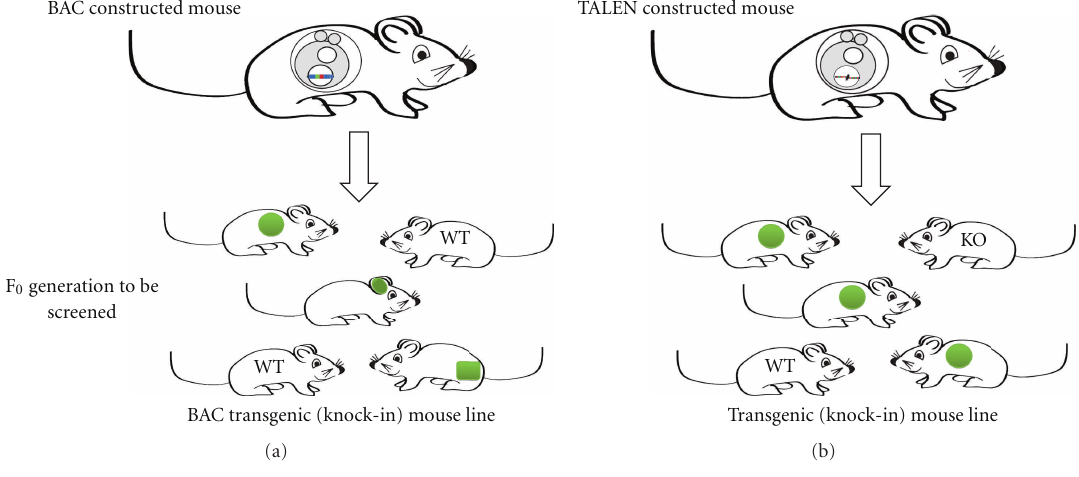
Figure 2: Generation of new mouse lines through BAC transgenesis or TALEN-mediated transgene insertion. (a) In consequence of the random integration of the vector during the construction of BAC transgenic mice the founders need to be screened for the appropriate expression pattern. (b) In contrast, TALEN-constructed transgenic mice only need to be checked by molecular biology methods for presence of the appropriate knock-in event. As a side product, knock-out alleles are usually generated as